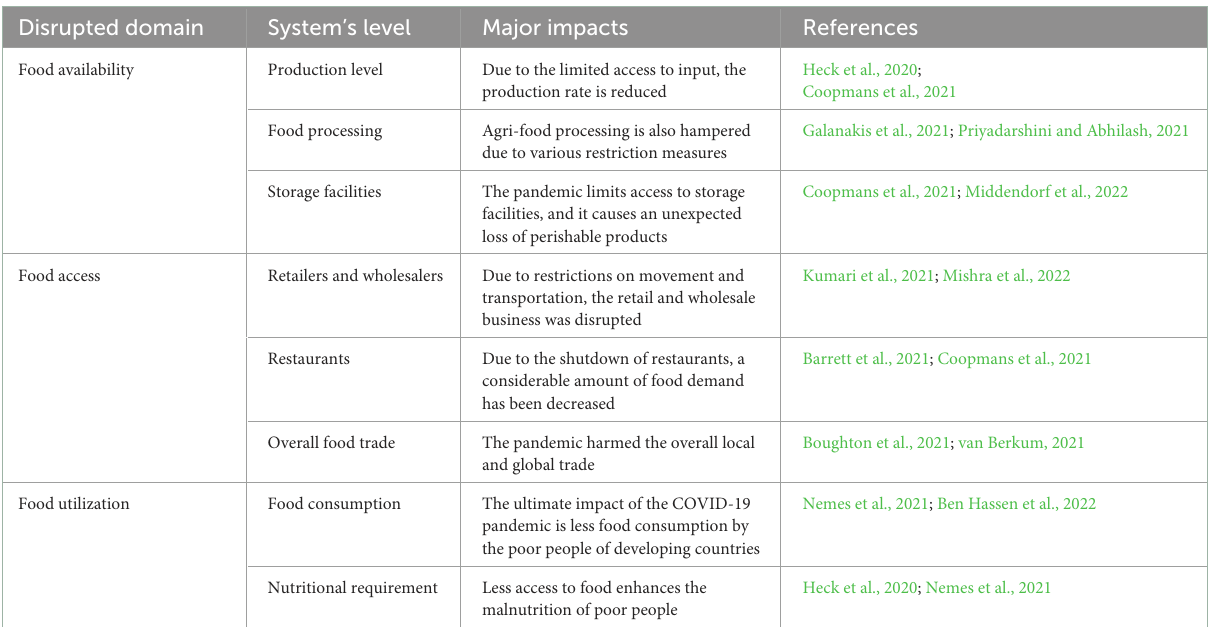
TABLE 3 COVID-19’s impact on